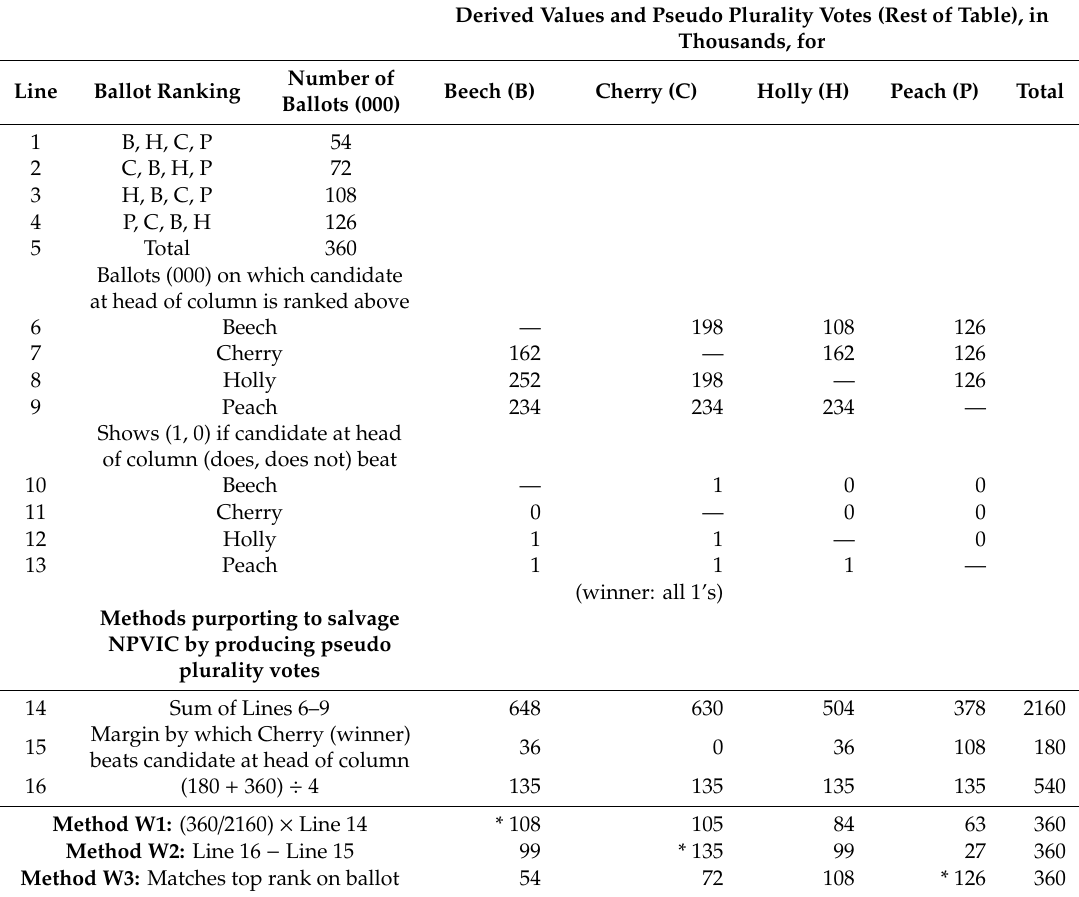
Table 9. Details for Condorcet voting for Wyoming (2024 election, Scenario 3). Condorcet Votes or Indicators (Lines 6–13) or Derived Values and Pseudo Plurality Votes (Rest of Table),